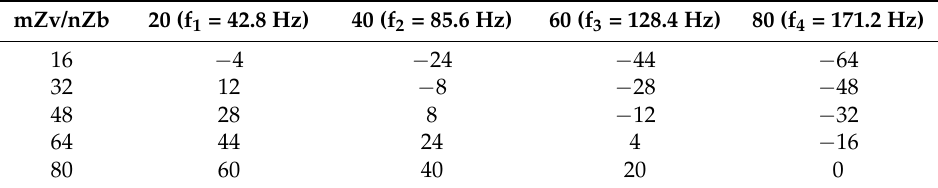
Table 1. Excitation shape (k m,n ) table for a combination of Z b = 16 and Z v = 20 runner blades. The most important components are colored in